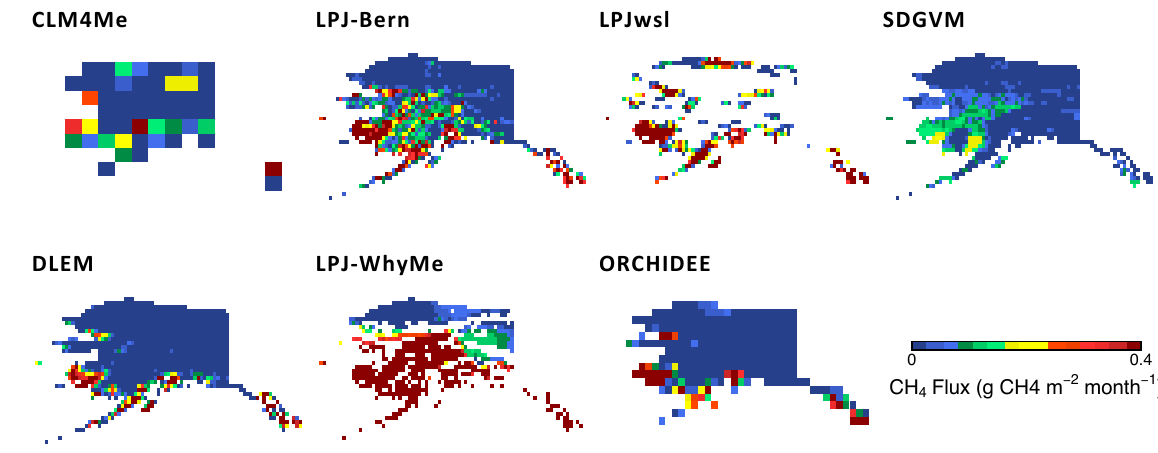
Figure 4. Mean annual (2003) net CH 4 flux for Alaska. Model output was part of the WETCHIMP model intercomparison project. 951